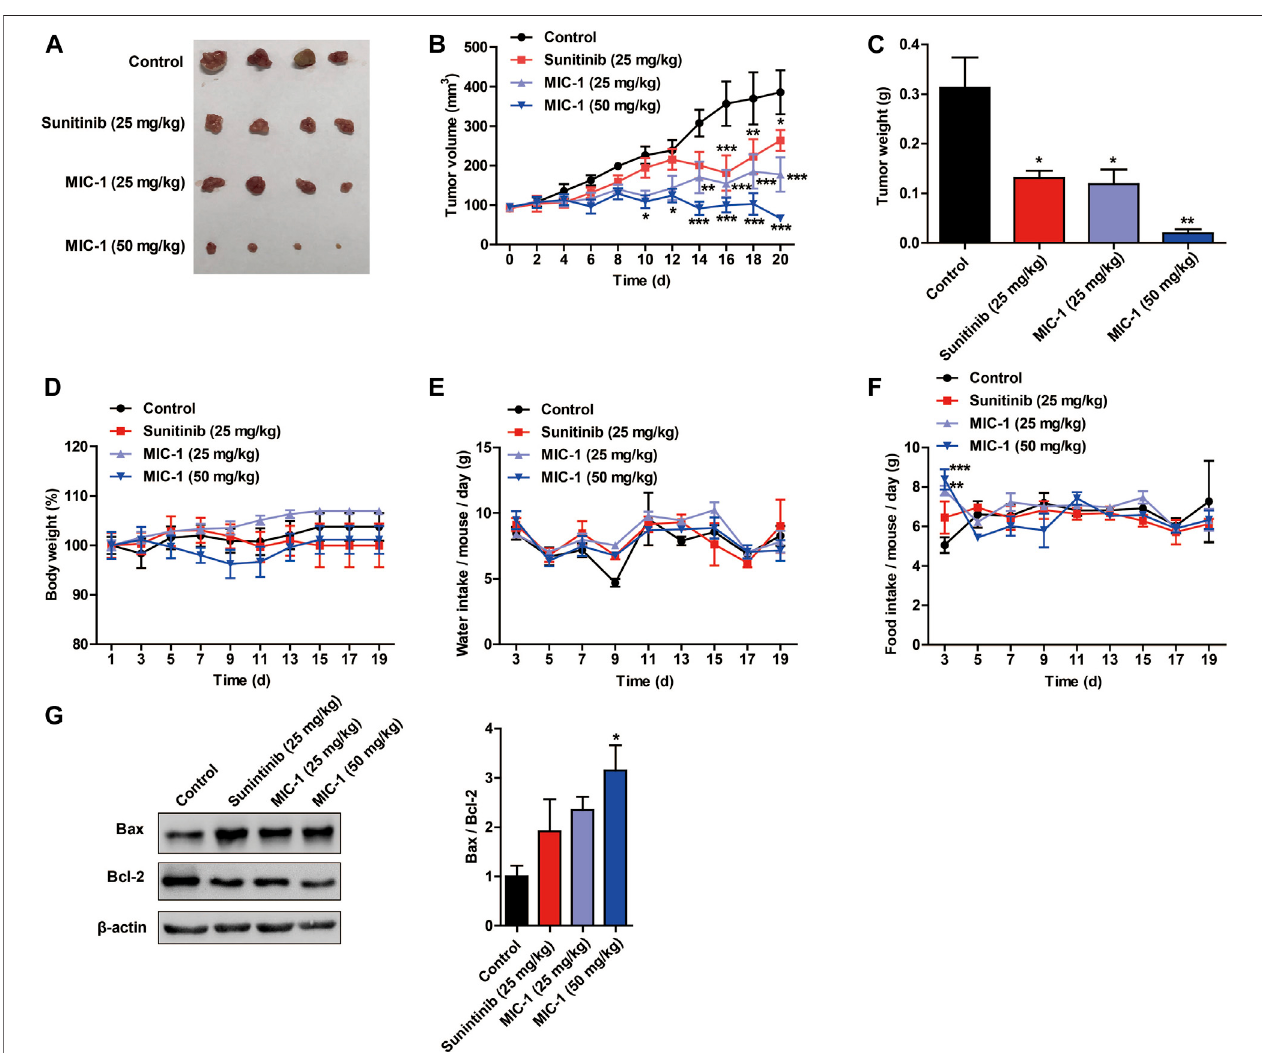
FIGURE 6 | MIC-1 inhibits the growth of subcutaneous xenograft tumors in vivo . 786-O cells were injected subcutaneously into nude mice to evaluate the in vivo effectsofMIC-1. (A) Representativeimagesofthetumorsareshown.Changesintumorvolume (B) ,tumorweight (C) ,bodyweight (D) ,waterintake (E) ,andfoodintake (F) inthedifferentgroupsofnudemice. (G) WesternblottinganalysiswasusedtodeterminetheproteinlevelsofBaxandBcl-2,with β -actinservingasaloadingcontrol. The results are expressed as the means ± SEM from three independent experiments and statistical analysis was performed by one-way ANOVA or two-way ANOVA. * p < 0.05, ** p < 0.01, *** p < 0.001: MIC-1 compared with the control.